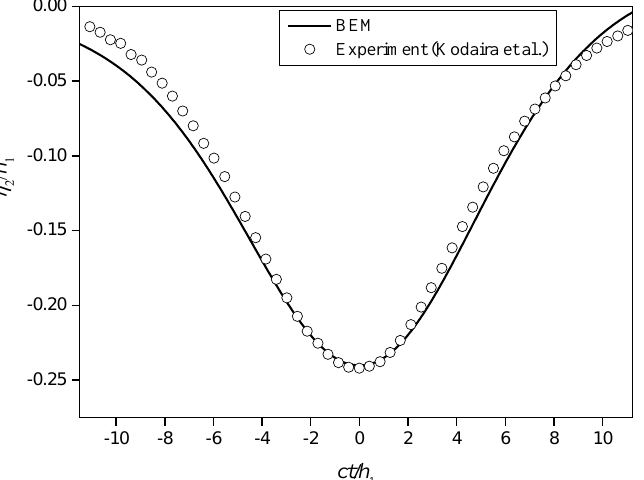
Figure 5. Comparison of the computations and experiments [47] for the time history of the interface displacement of the internal wave.